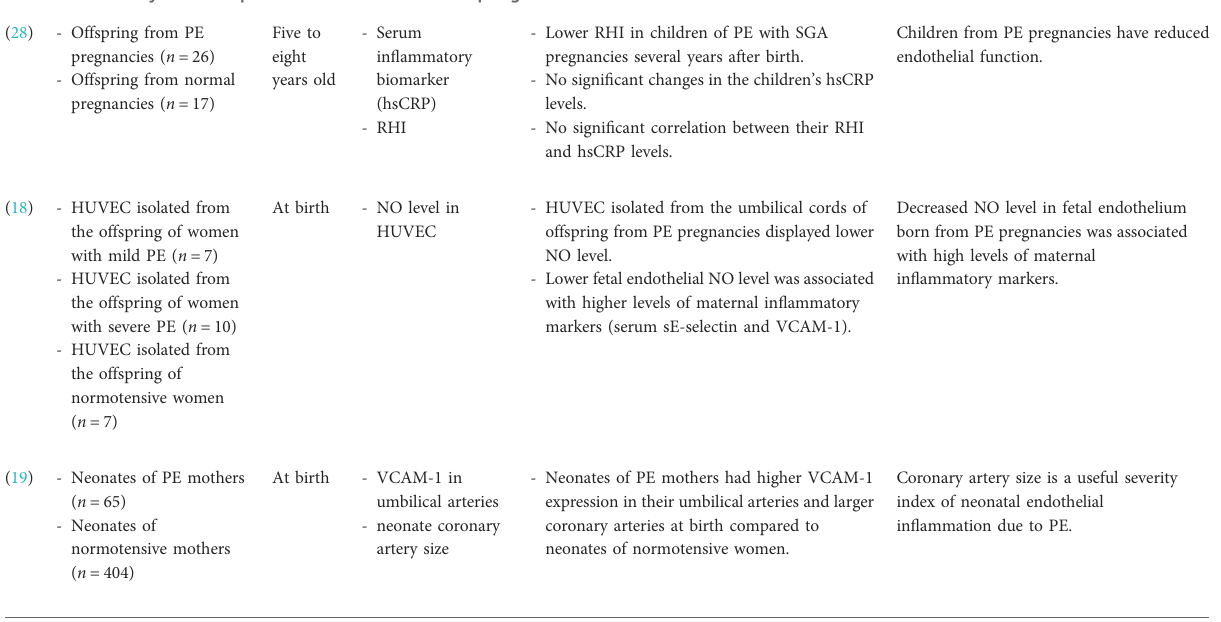
TABLE 2 Summary of the impact of de novo HDP on offspring endothelial in fl ammation and function. (28) - Offspring from PE pregnancies ( n =26) - Offspring from normal pregnancies ( n